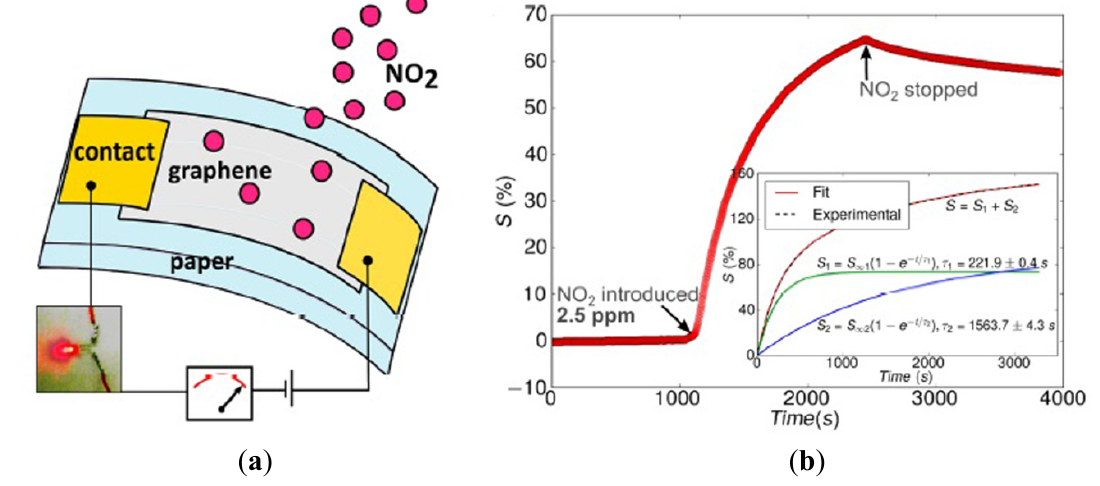
Figure 2. ( a ) Schematic of a G-paper strip based gas sensor; ( b ) Response of a G-paper strip to 2.5 ppm of NO 2 . Inset shows a fit of double exponential function to the temporal response for 2.5 ppm of NO 2 . The two constituent exponentials are also shown along with the estimates of time-constants. Reprinted with permission from Ref. [55].